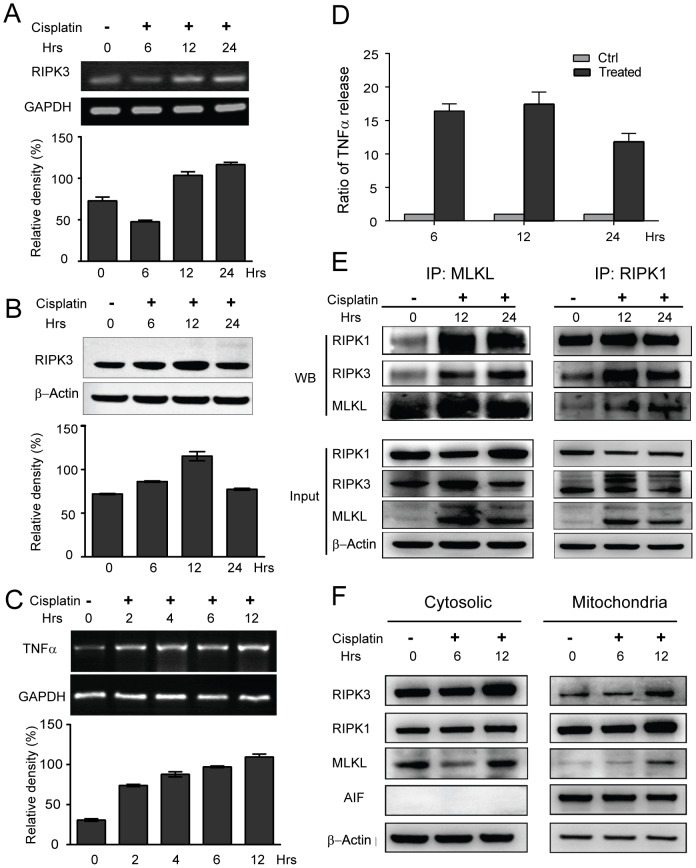
Cisplatin triggers the assembly of necrosome via autocrine production of TNFα in KYSE140 cells.(A) KYSE140 cells were treated with 10 µM cisplatin for 6, 12, or 24 h, and the RIPK3 mRNA level was determined by RT-PCR. The relative density was compared to the GAPDH control. (B) The RIPK3 protein expression was determined by western blot analysis. The levels of RIPK3 protein were quantified and normalized to β-Actin. (C) Cisplatin promotes TNFα transcription. KYSE140 cells were treated with 10 µM cisplatin for the indicated time points, and the TNFα mRNA levels were analyzed by RT-PCR. The relative density was compared to the GAPDH control. (D) Cisplatin promotes autocrine production of TNFα. KYSE140 cells were treated with cisplatin for the indicated time points, and the level of TNFα secretion in the supernatant was measured by ELISA. (E) RIPK3 interacts with RIPK1 and MLKL. After treatment with cisplatin for 12 and 24 h, RIPK1 and MLKL were immunoprecipitated using anti-RIPK1 or anti-MLKL antibodies. RIPK1, RIPK3 and MLKL were detected by western blot analysis. (F) KYSE140 cells were treated with 10 µM cisplatin for 6 or 12 h. Mitochondrial and cytosolic fractions were isolated from the treated cells and analyzed for the indicated proteins with western blotting. AIF was used as a control for mitochondrial fraction and loading.